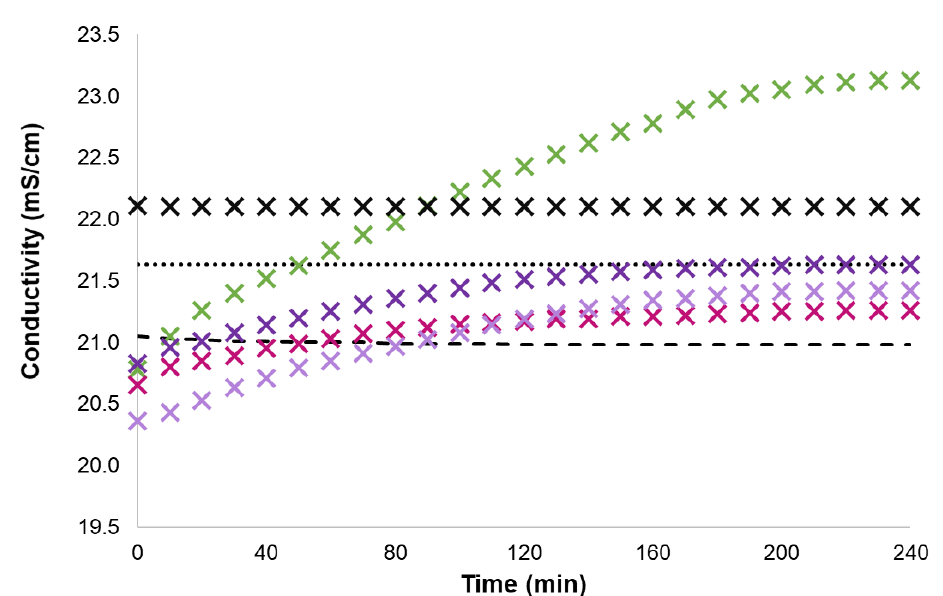
Figure 4. Conductivity data of 0.04 mol% GDIL IMCn series and BTF6, and of 0.08 mol% KCl in [C 2 mim][SCN] solution upon UV irradiation time at 25 ◦ C (round dot—pure [C 2 mim][SCN], dash—BTF6, X black cross—KCl, X green cross—IMC1, X blue cross—IMC2, X gold cross—IMC4, X gray cross—IMC6, X orange cross—IMC8, X blue-gray cross—IMBENZ).